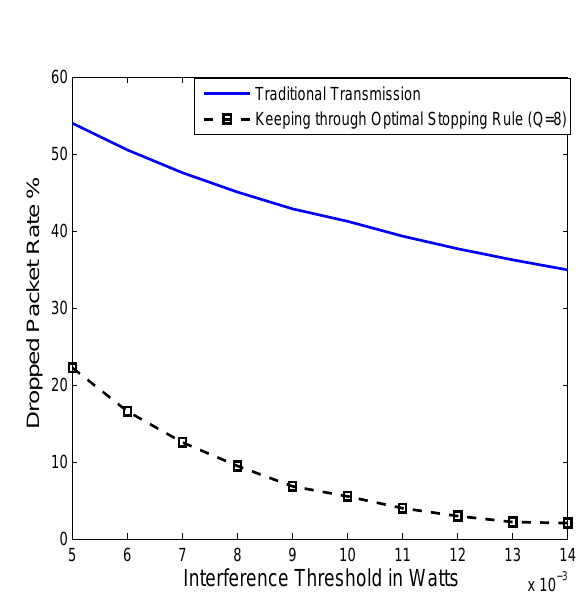
Figure 3. APTP through traditional transmission method and OSP versus Queue Size and Interference